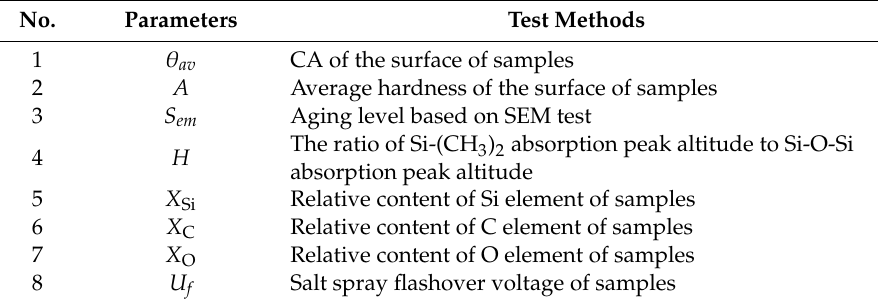
Table 8. Lifespan prediction parameters of